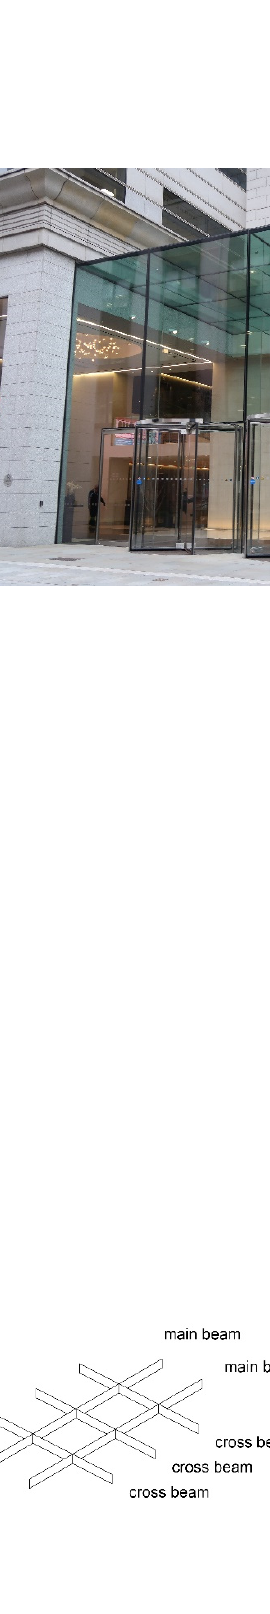
Figure 23. Arrangement of beams in the grillage: ( a ) hierarchy of beams; ( b ) lamellar system (figures by the author).